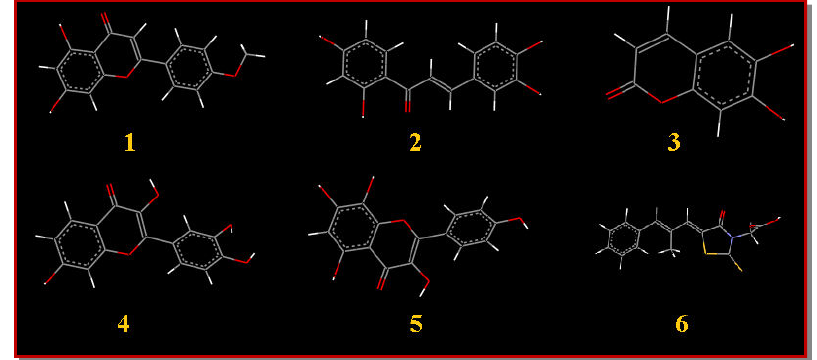
Figure 2: The optimized ligand molecules ( 1 biochanin, 2 butein, 3 esculatin, 4 fisetin, 5 herbacetin and 6